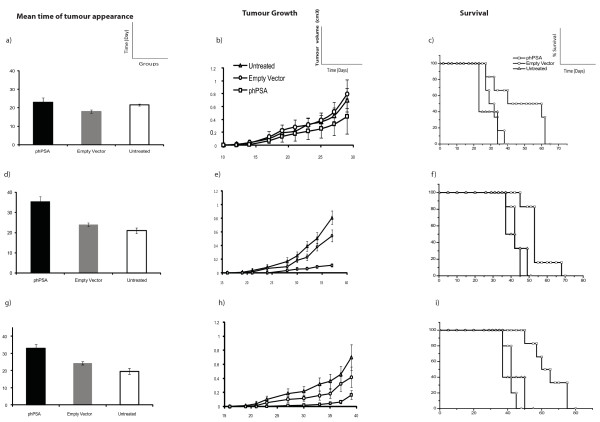
Tumour protective effects of the various vaccination regimens. (n = 6) Regimen 1 - a) Time of tumour appearance - the mean time of tumour appearance was comparable in various groups (p = 0.07). b) Representative tumour growth curve - phPSA immunised mice had low tumour volumes but the difference was not significant (p vs empty vector = 0.34, vs untreated = 0.27). c) Representative Kaplan Meyer survival curve - mean survival in the immunised group was significantly prolonged (p vs empty vector = 0.04, vs untreated = 0.03). Regimen 2 - d) Time of tumour appearance - the phPSA treated mice remained tumours free for prolonged period of time (p < 0.01). e) Representative tumour growth curve - tumour growth was retarded in the immunised group. The tumour volumes were significantly lower than the untreated group at all time points (p = 0.04), but not when compared with empty vector group (p = 0.07). f) Representative Kaplan Meyer survival curve - immunisation with phPSA provided significant prolonged survival of the treated mice (p vs empty vector = 0.01, vs untreated = 0.01). Regimen 3 - g) Time of tumour appearance - mean time of tumour appearance was delayed significantly as compared to both control groups (p < 0.01). h) Representative tumour growth curve - tumour growth was significantly retarded in phPSA immunised group (p vs empty vector = 0.04, vs untreated = 0.01). i) Representative Kaplan Meyer survival curve - average survival in immunise group was significantly prolonged (p vs empty vector < 0.01, vs untreated < 0.01). Data are expressed as means ± SEM.